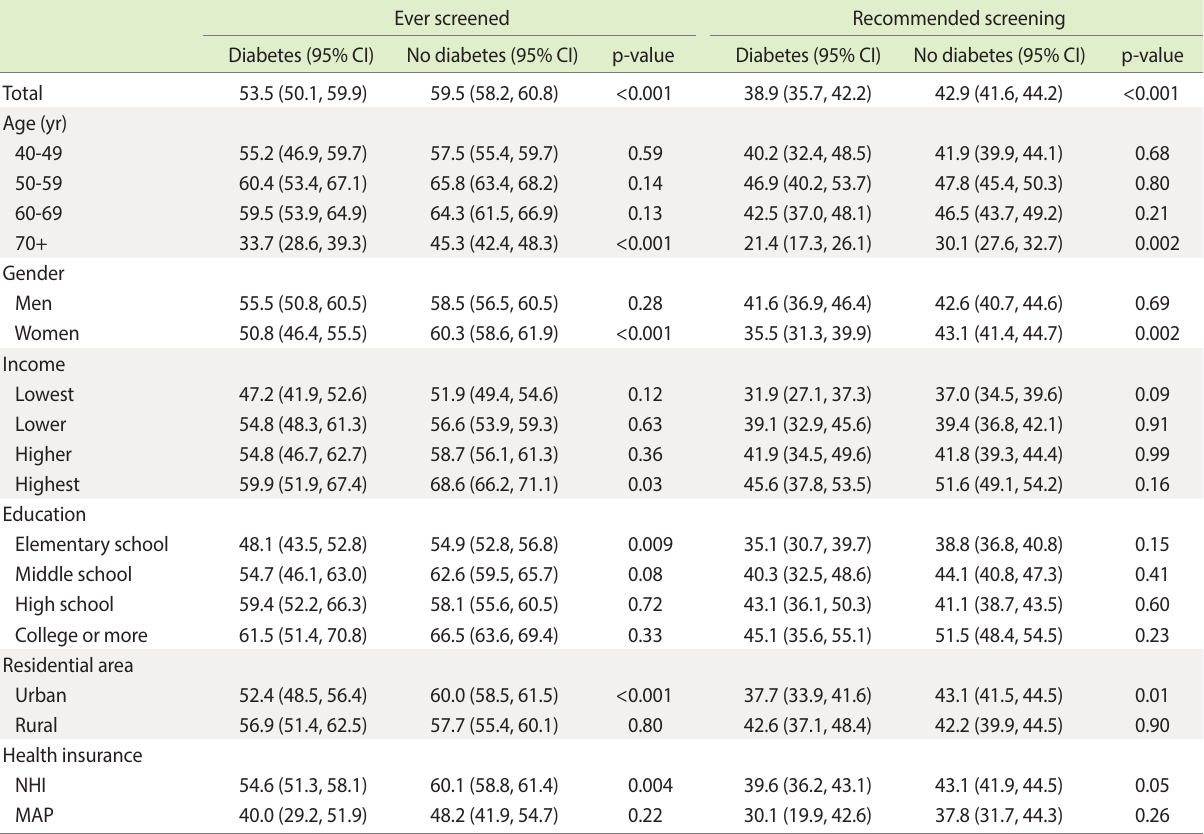
Table 2. Gastric cancer screening rate in diabetic and non-diabetic participants (ever screened and recommended screening) Ever